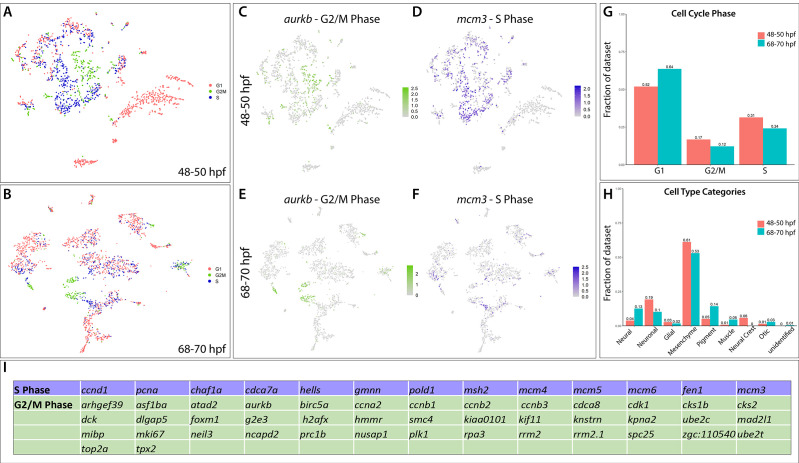
Major cell type categories and cell cycle distributions of the scRNA-seq datasets.(A,B) tSNE plots summarizing the G1, S, and G2/M phase cell cycle phase occupancies of the cells in the 48–50 and 68–70 hpf time points, respectively. (C,E) A tSNE plot depicting the expression of aurkb, a G2/M phase marker, within the 48–50 and 68–70 hpf datasets, respectively. Relative expression levels are summarized within the color keys, where color intensity is proportional to expression level of each gene depicted. (D,F) A tSNE plot depicting the expression of mcm3, a S phase marker, within the 48–50 and 68–70 hpf datasets, respectively. Relative expression levels are summarized within the color keys, where color intensity is proportional to expression level of each gene depicted. (G) Bar graphs summarizing the cell cycle phase occupancies, as a fraction of cells within the total datasets for each time point. (H) Bar graphs summarizing the major cell type categories, as a fraction of cells within the total datasets for each time point. (I) Table summarizing the cell cycle genes used to demarcate cell cycle phase occupancy categories within the scRNA-seq datasets.